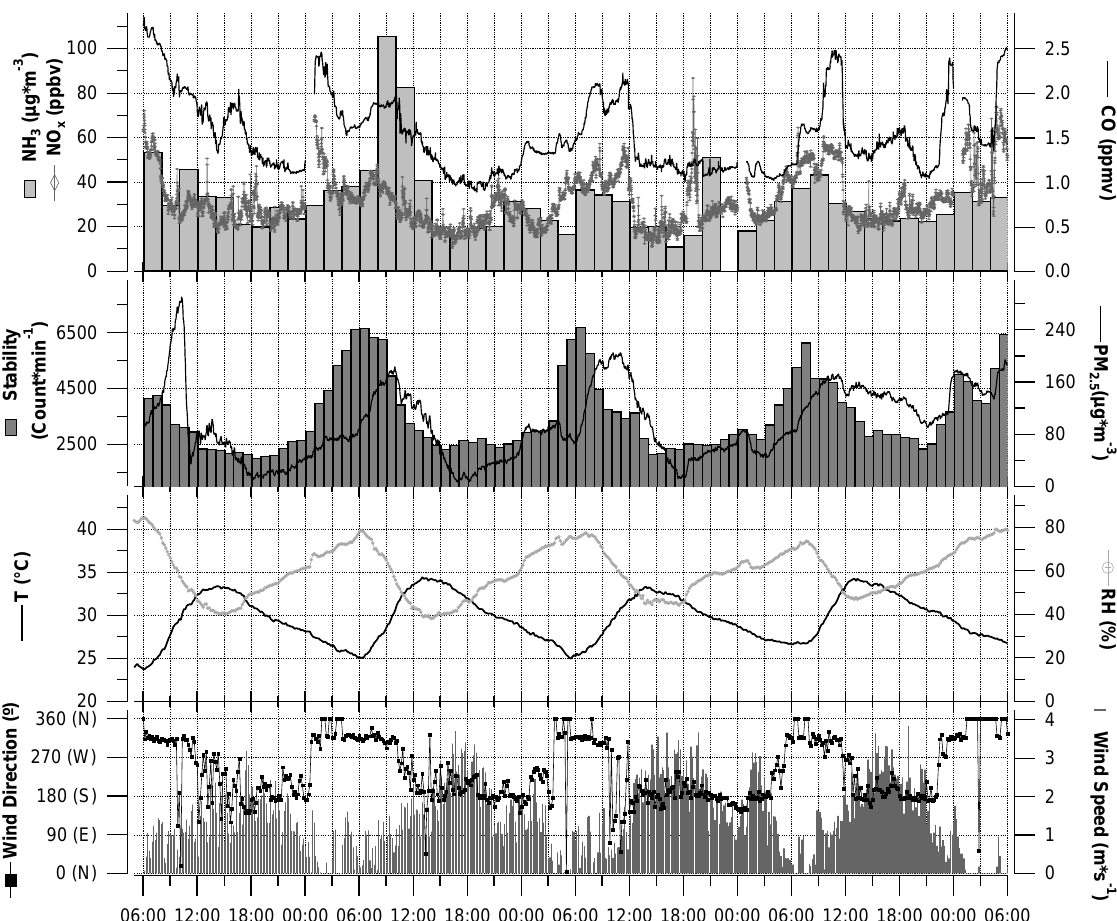
Fig. 8. Diurnal trends of NH 3 , NO x , CO, PM 2 . 5 , temperature ( T ), relative humidity (RH), wind speed and direction during the intensive summer